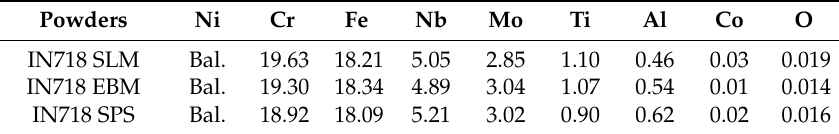
Table 1. Practical compositions of the raw powders used in this study (in